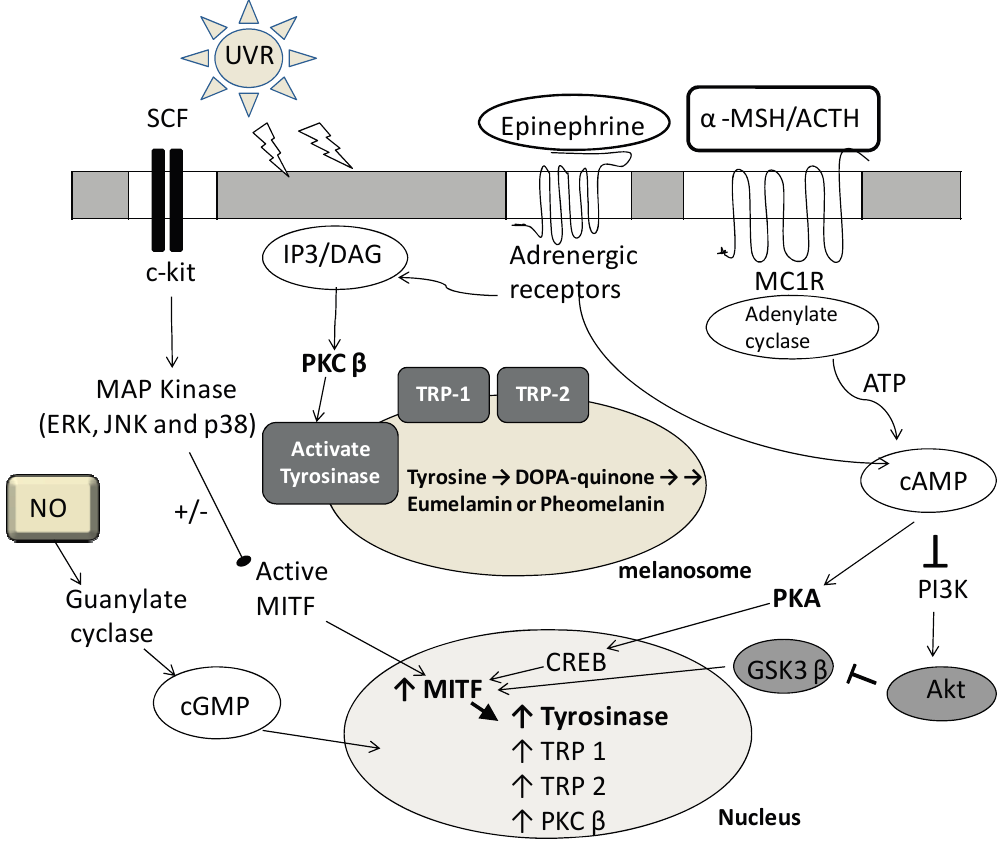
Figure 1. Scheme presentation of different signal pathways to regulate